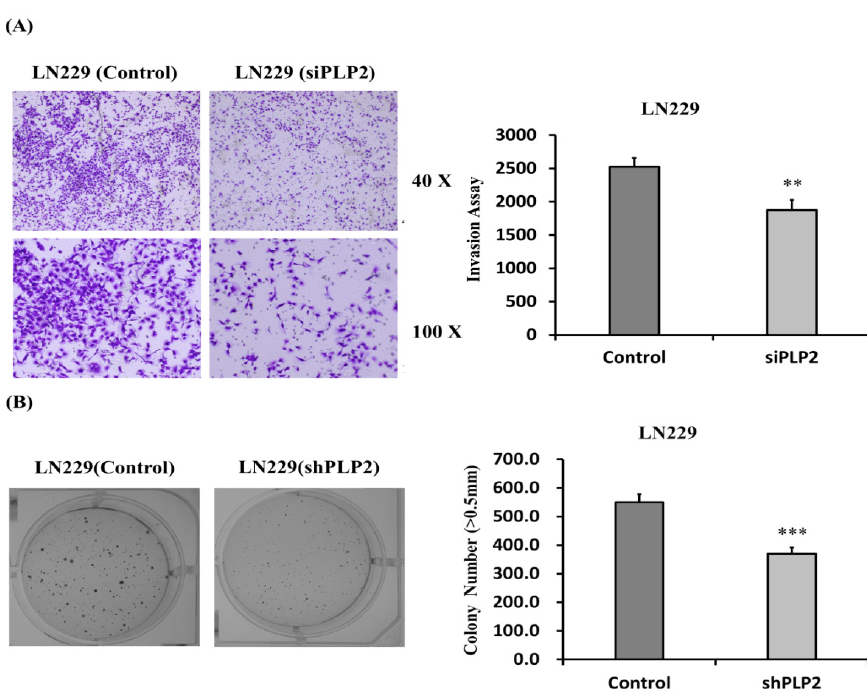
Figure 7. ( A ) The cell invasive ability in LN229 glioma cell line with siPLP2 transfection was lower than NC transfection after 24 h incubation; ( B ) Similarly, siPLP2 transfected LN229 glioma cells revealed lesser cell colonies then NC transfected tumors. (** p < 0.01; *** p < 0.001).